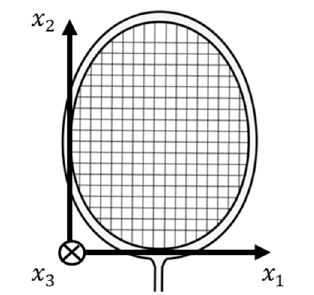
Figure 1. 3-Dimentional coordination system.